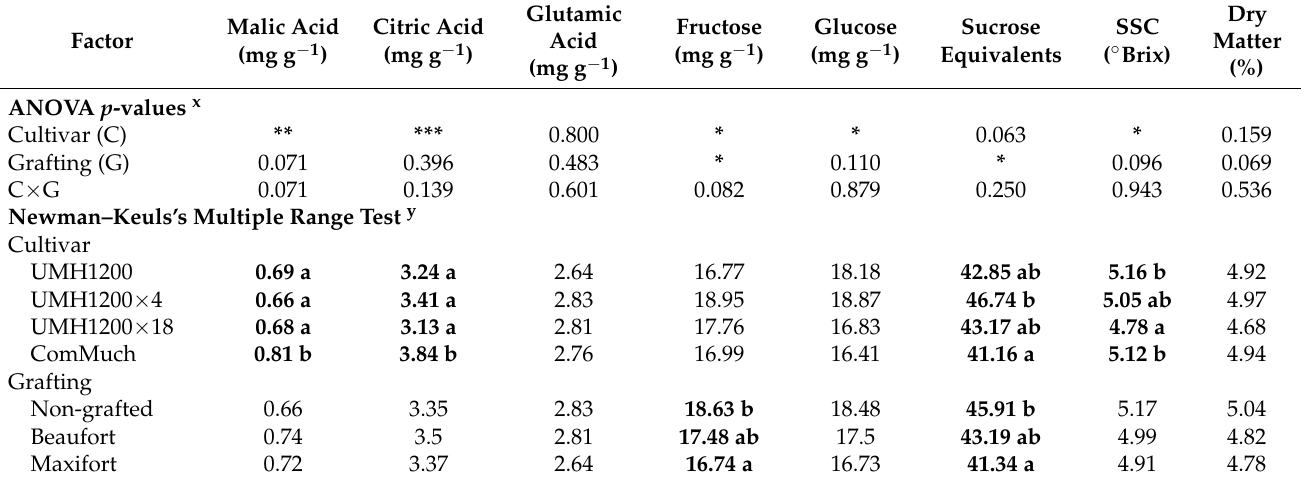
Table 3. Effect of grafting in the metabolic profile (organic acids, sugars, and dry matter content) of the fruits grown at CIAGRO-UMH (ANOVA and Tukey’s multiple-range test). ComMuch: Commercial Muchamiel. Bold format indicates statistical